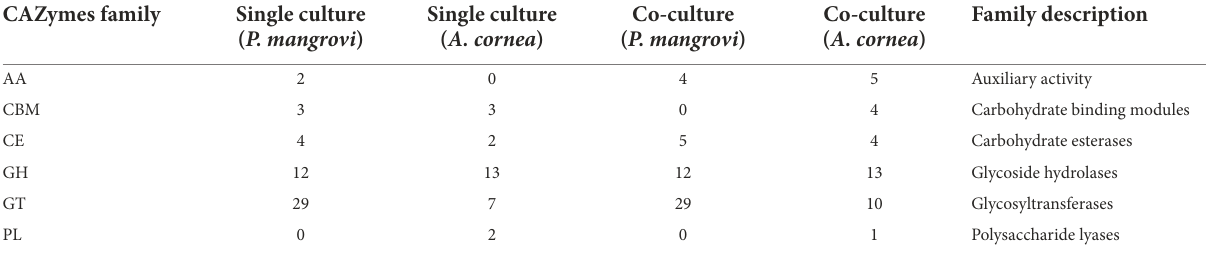
TABLE 2 Number of CAZy enzymes identified from the single- and co-culture conditions by dbCAN2. CAZymes